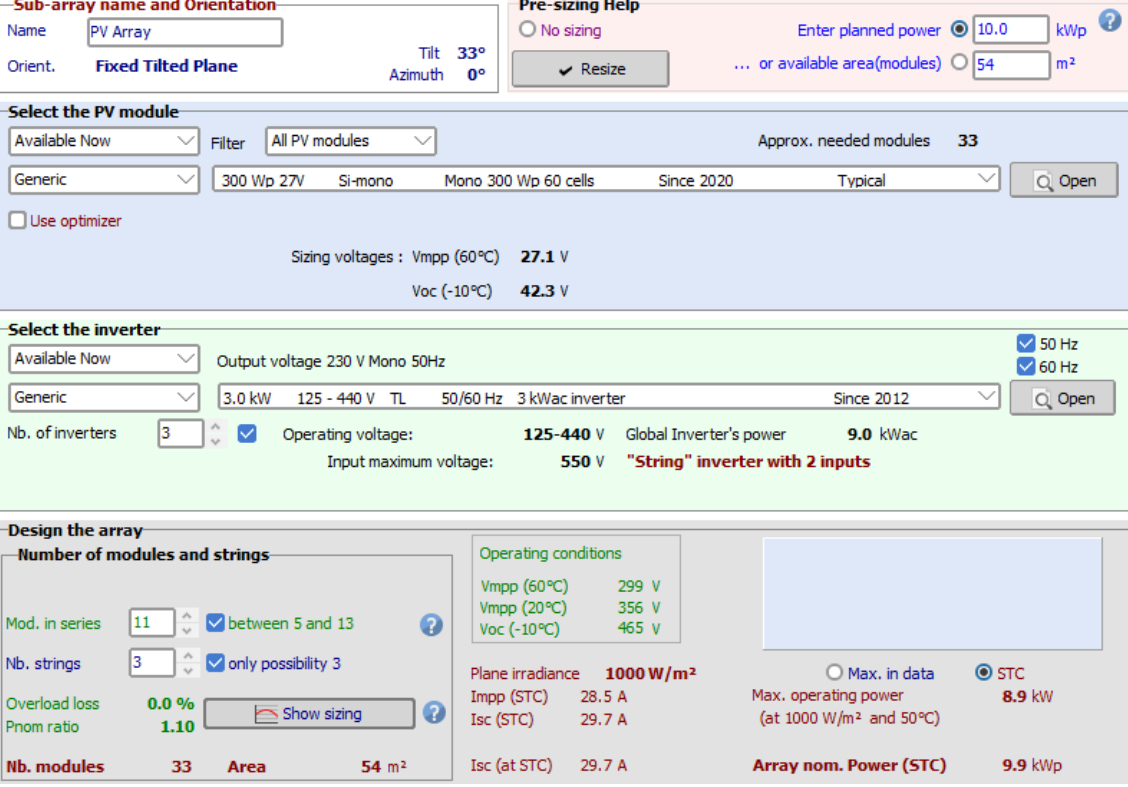
Figure 12. Project page layout and important se tt ings.